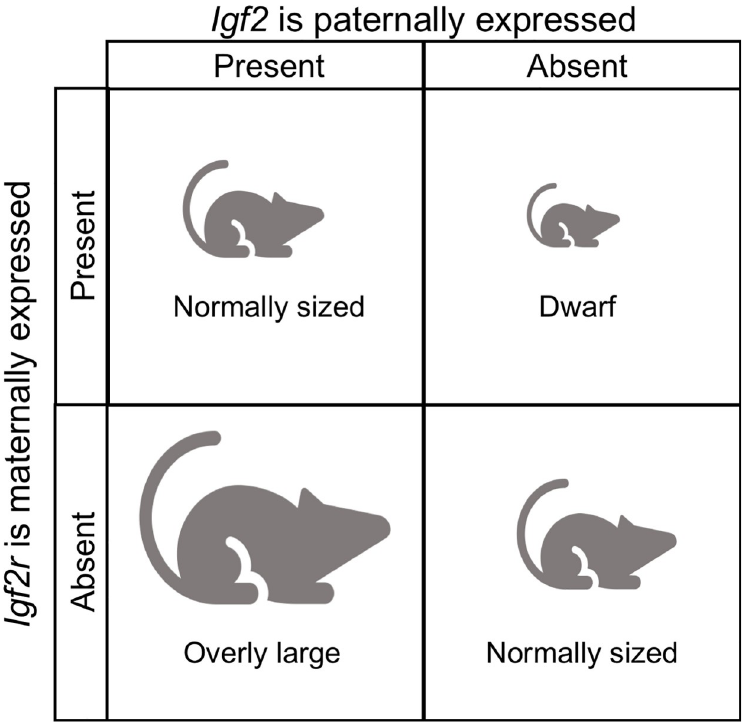
Fig 6. Igf2 is an example of genomic imprinting. In mice, the insulin-like growth factor 2 gene, Igf2 , which is linked to hormone production and increased offspring growth is paternally expressed (maternally silenced) and the insulin- like growth factor 2 receptor gene Igf2r , which binds the growth protein and so slows growth, is maternally expressed (paternally silenced). The offspring is normal sized when both genes are present, or both genes are absent. When the maternally expressed gene ( Igf2r ) is experimentally knocked out the offspring has an unusually large size, and when the paternally expressed gene ( Igf2 ) is knocked out, the offspring is unusually small.